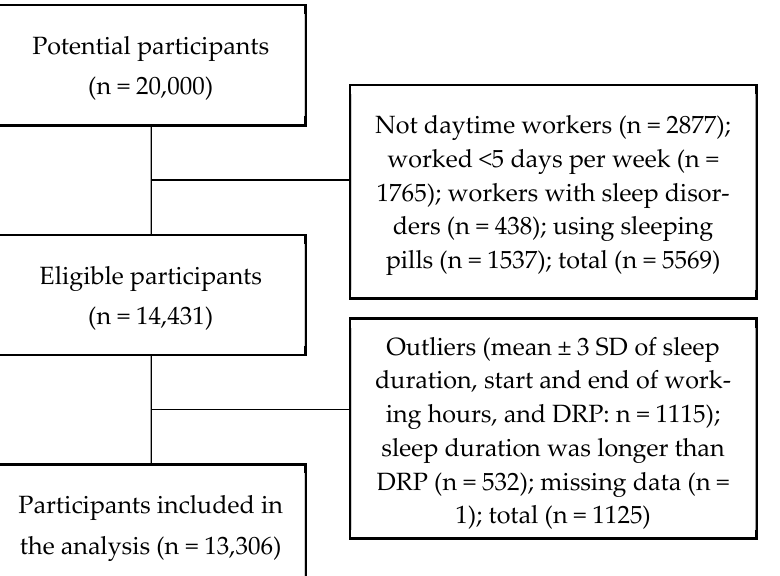
Figure 1. Participant enrolment. SD, standard deviation; DRP, daily rest period.